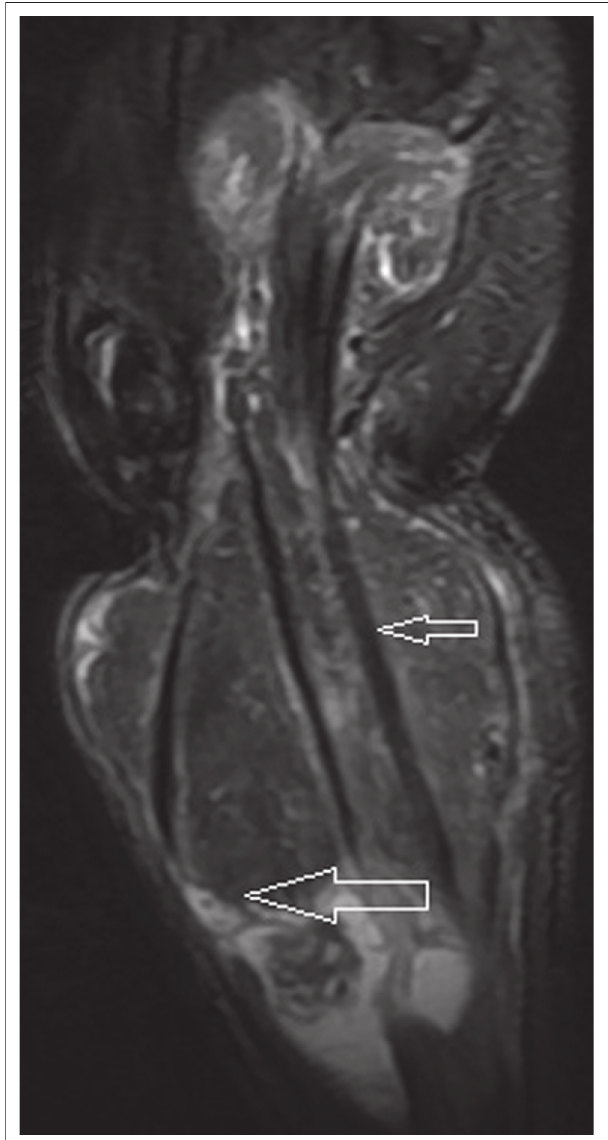
FIGURE 3: Coronal T2-weighted fat-suppressed image demonstrates a mixed signal intensity lesion containing solid-cystic components (larger arrow) encasing the flexor tendon sheaths (smaller arrow) both above and below the flexor retinaculum.